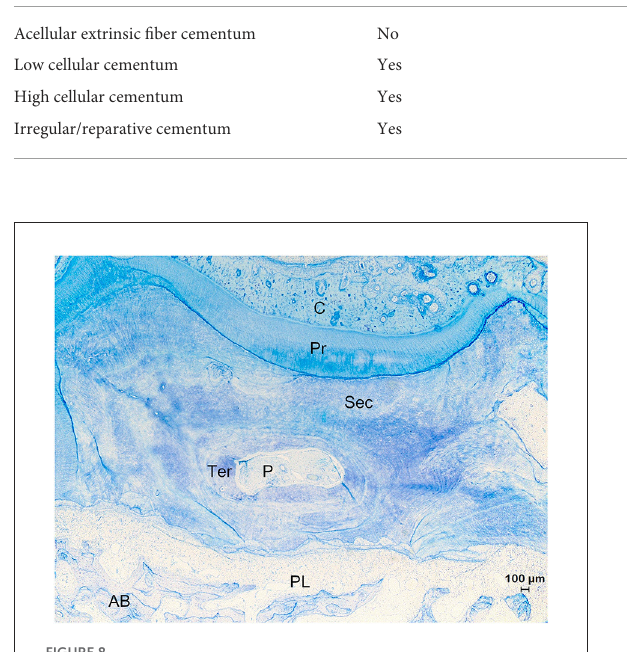
FIGURE8 Histological section of the apical region of root IV of a 7 years and 5 months old first molar in the right upper jaw (Animal age of 8 years). Example of a tooth which experienced a drift. The top of the figure shows the tension side with cementum (C) holding vascular canals and irregular resting lines indicating a history of episodes of resorption and reparation. At the tension side, the tooth showed a movement in a direction away from the alveolar bone (AB) whereby large amounts of